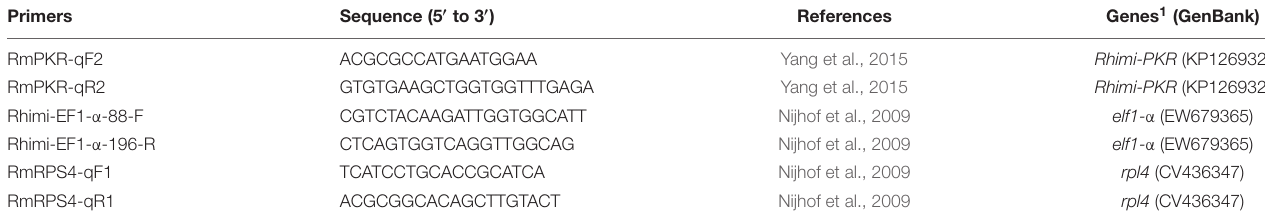
TABLE 1 | Primers used for RT-qPCR. Primers